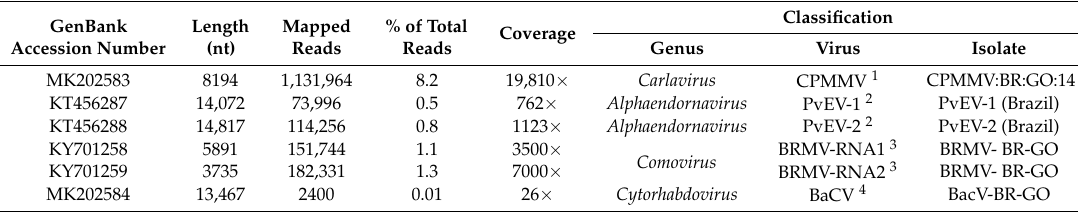
Table 2. Viral genomes found infecting the bean golden mosaic virus (BGMV)-resistant CNFCT16207 common bean transgenic line.